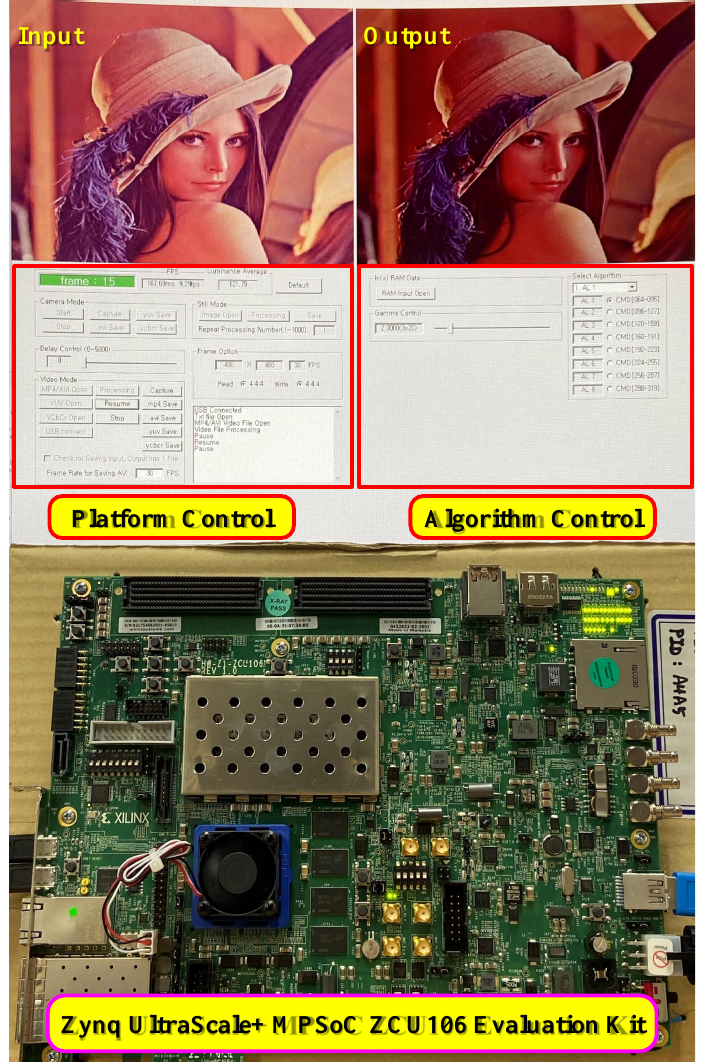
Figure 12. Real-world execution of the proposed run-time reconfigurable gamma